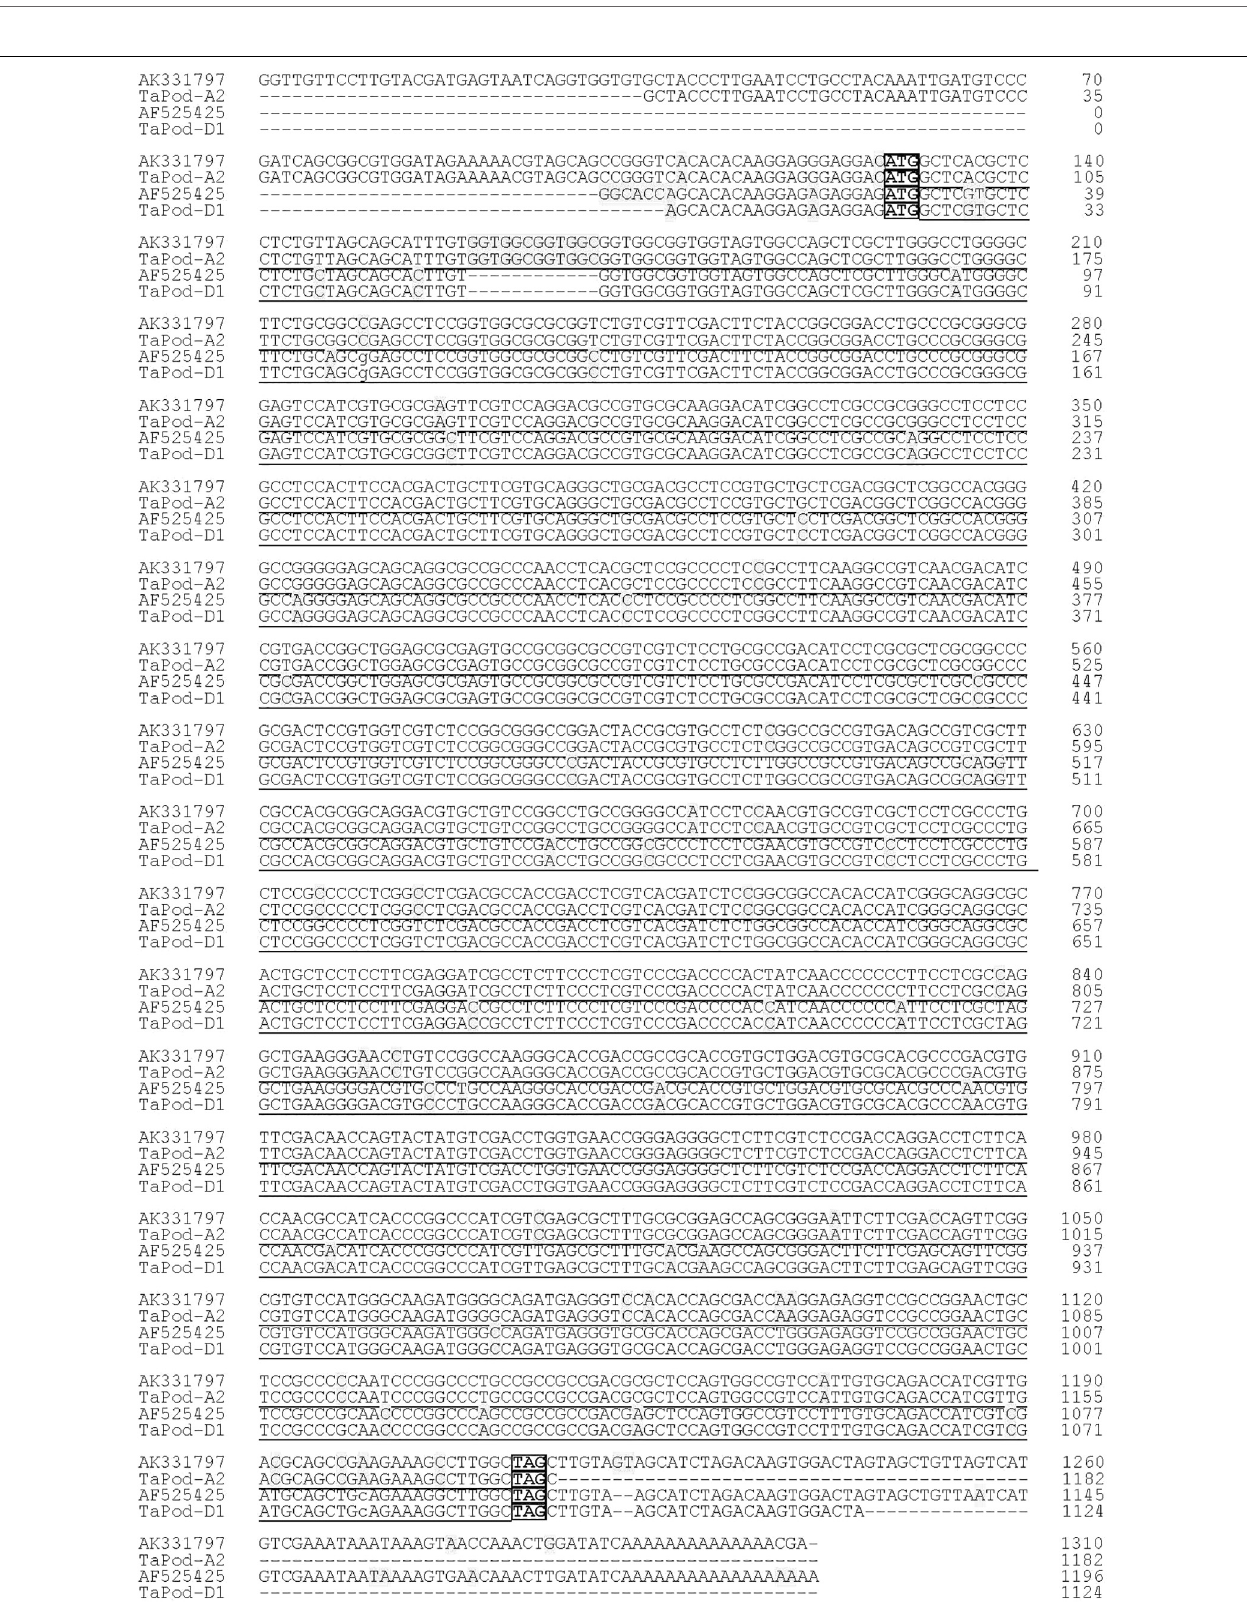
Frontiers in Plant Science |